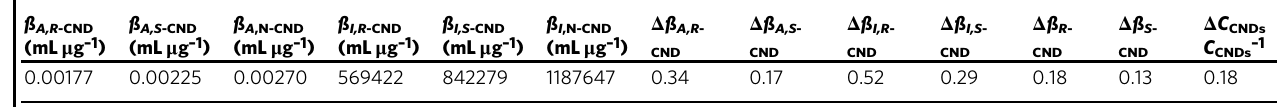
Table 1 Error analysis in concentration determination by absorption ( A 280 ( C CNDs )) and fl uorescence intensity ( I max ( C CNDs ))